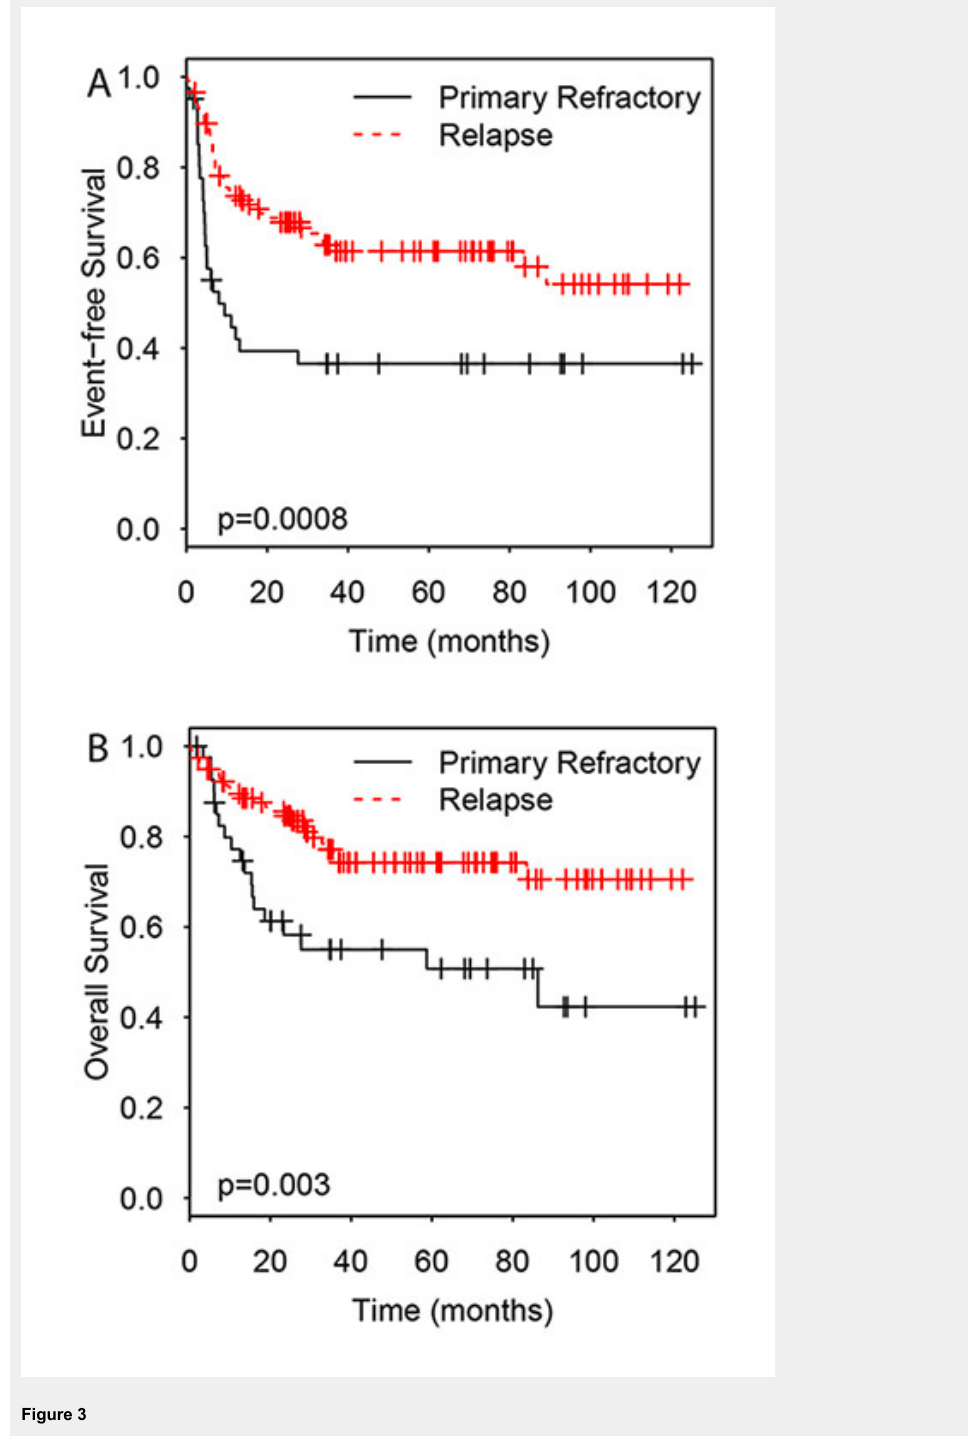
Figure 3 Impact of chemosensitivity to primary chemotherapy on event free survival (A) and overall survival